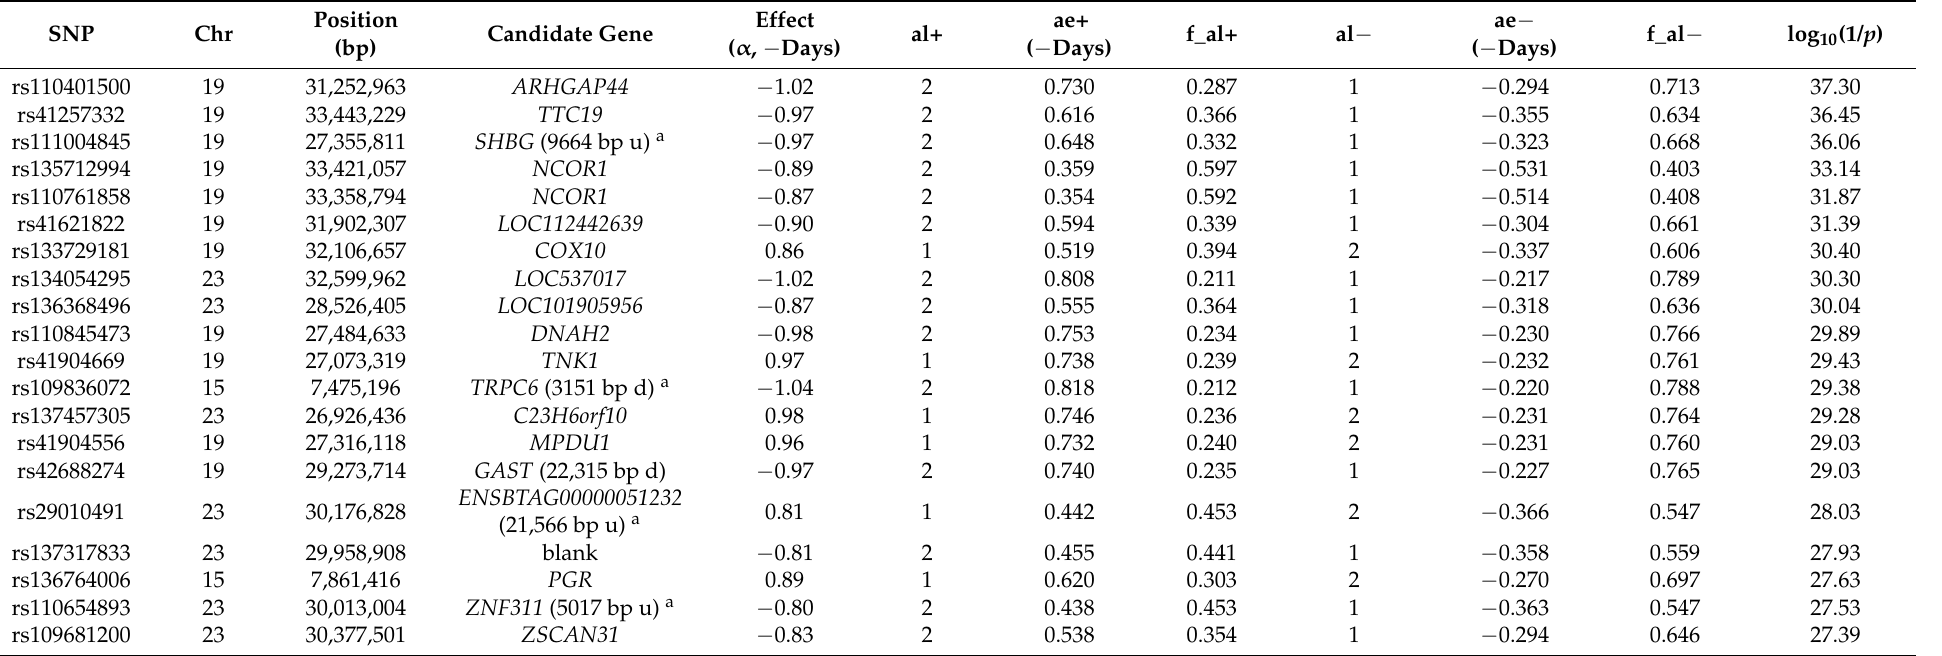
Table 1. Top 20 significant additive effects for